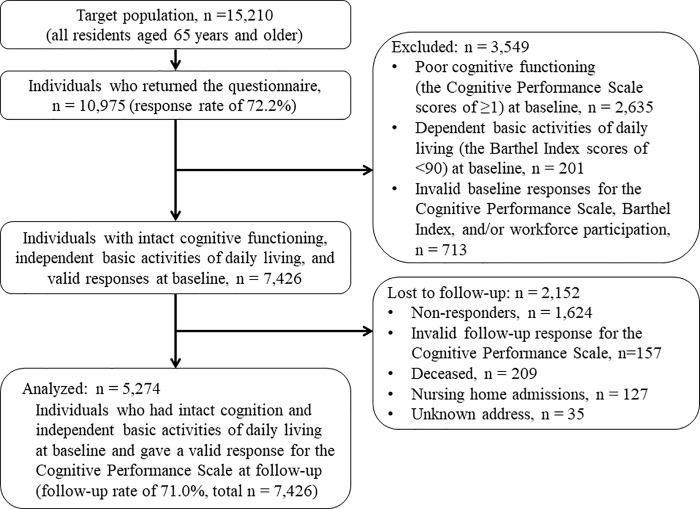
Flow chart of study participants.